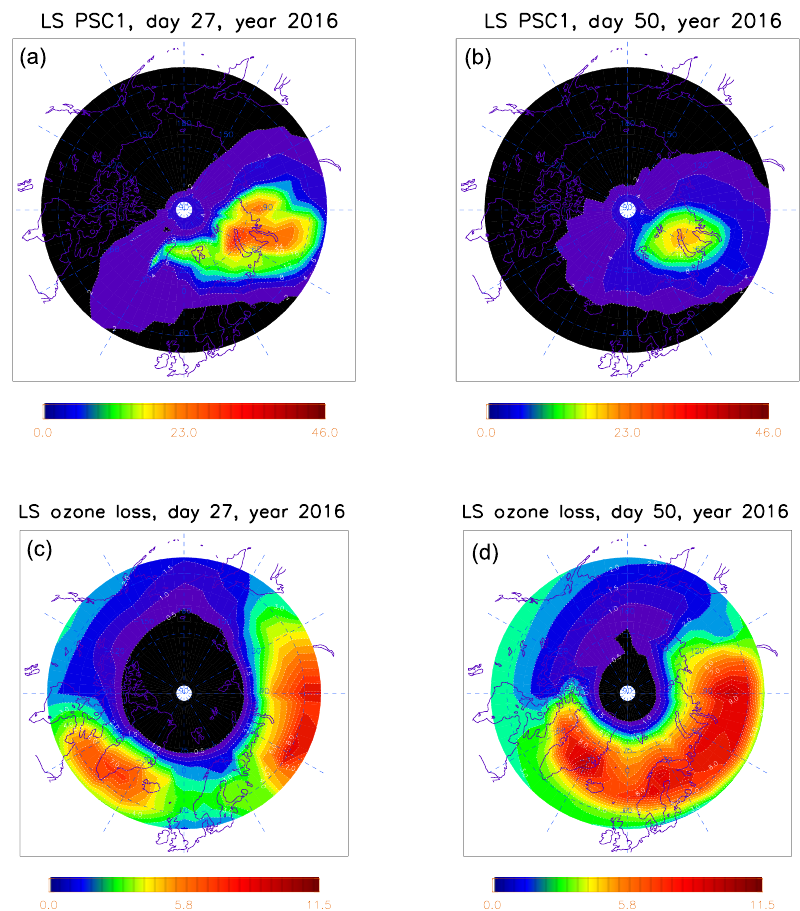
Figure 5. Polar stratospheric cloud surface area (10 8 cm 2 cm − 3 ) for days with minimum local registered column ozone values (27 January, a, c , and 19 February, b, d ), simulated with the RSHU model (a, b) and averaged ozone loss coefficient (10 8 s − 1 ) of the lower stratosphere for the same days (c, d)